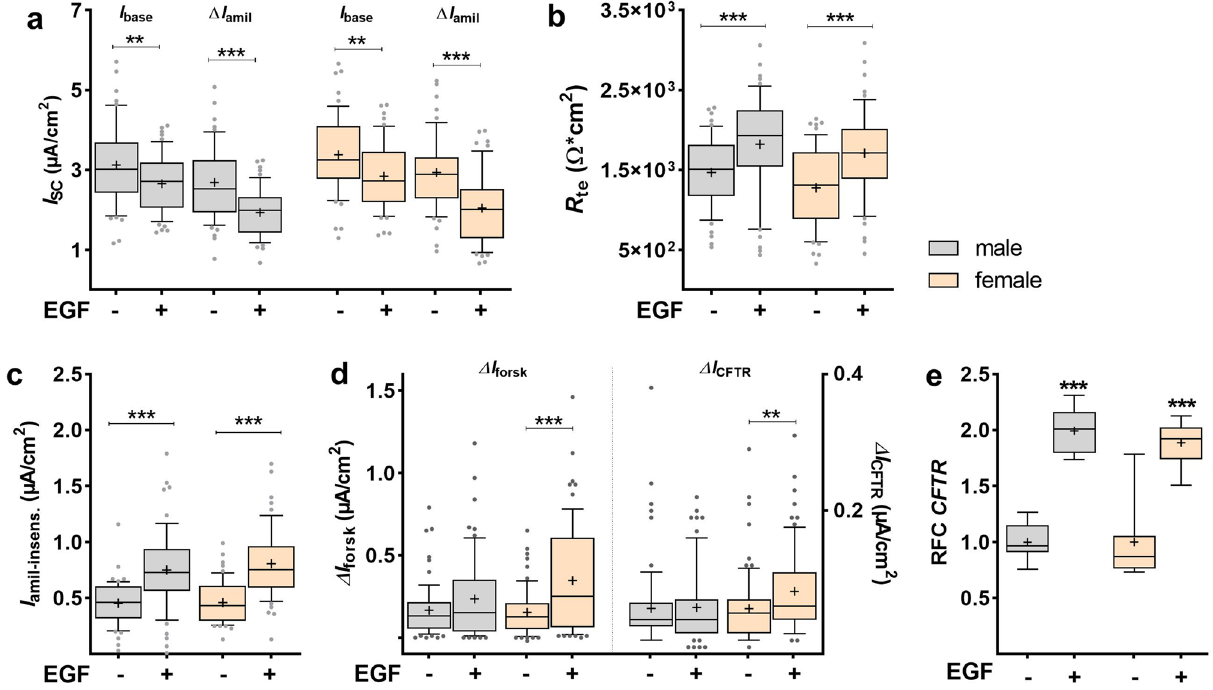
Figure 2. EGF decreased Na + transport, but increased Cl − transport and CFTR mRNA expression. FDLE cells were cultured in SF-Med and stimulated with EGF for 24 h. Data are displayed as box and whiskers with the 10–90 percentile, mean (+) and median (horizontal line). ( a ) In male and female FDLE cells, EGF significantly decreased I base and Δ I amil (n = 52–59; ** p < 0.01; *** p < 0.001 by t -test). EGF further significantly increased R te ( b ) and I amil-insens ( c ) in both sexes (*** p < 0.001). ( d ) EGF strongly increased Δ I forsk and Δ I CFTR , but only in female FDLE cells (n = 71–76; ** p < 0.01; *** p < 0.001 by t -test). ( e ) EGF significantly increased CFTR mRNA expression in both sexes (n = 8; *** p < 0.001; t -test). (Grey boxes) male; (yellow boxes) female.